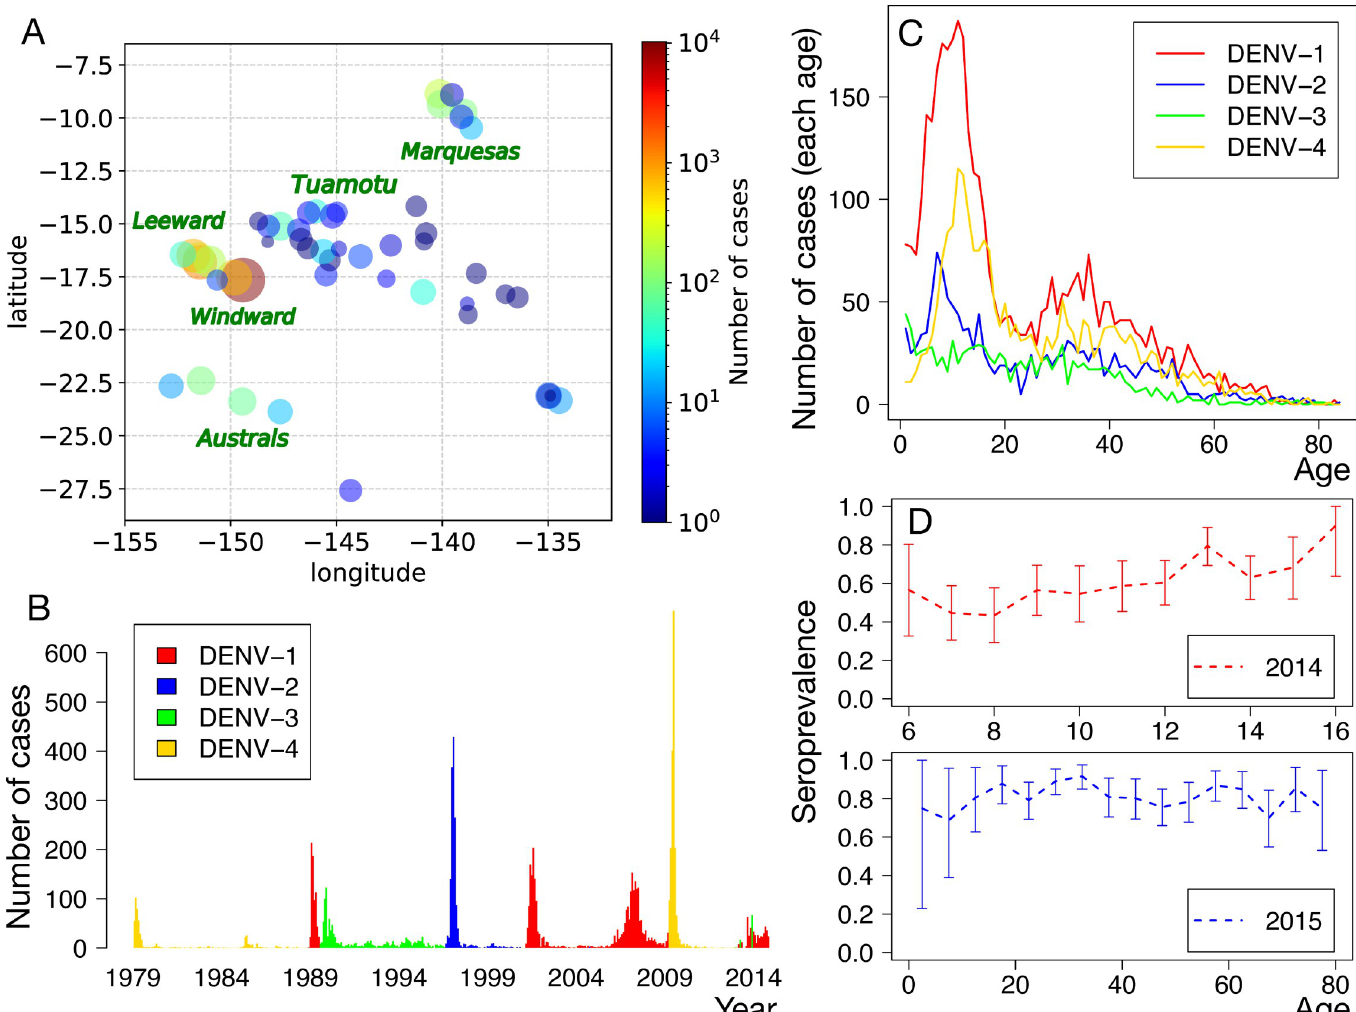
Fig 1. Epidemiology of dengue in French Polynesia (directly obtained from data). ( A) Spatial distribution of the number of cases reported between 1979 and 2014, in the different islands of French Polynesia. Each circle represents the size of the population, where the radius is defined as 0.2log 10 P with the population size P. The colours of the circles represent the number of reported cases. ( B) Monthly number of cases reported for DENV-1 to DENV-4. ( C) Age distribution of cases, averaged over the period between 1979 and 2014. ( D) The results of serological surveys (seroprevalence of antibodies against DENV) conducted in 2014 and 2015. Error bars indicate 95%- Confidence Intervals